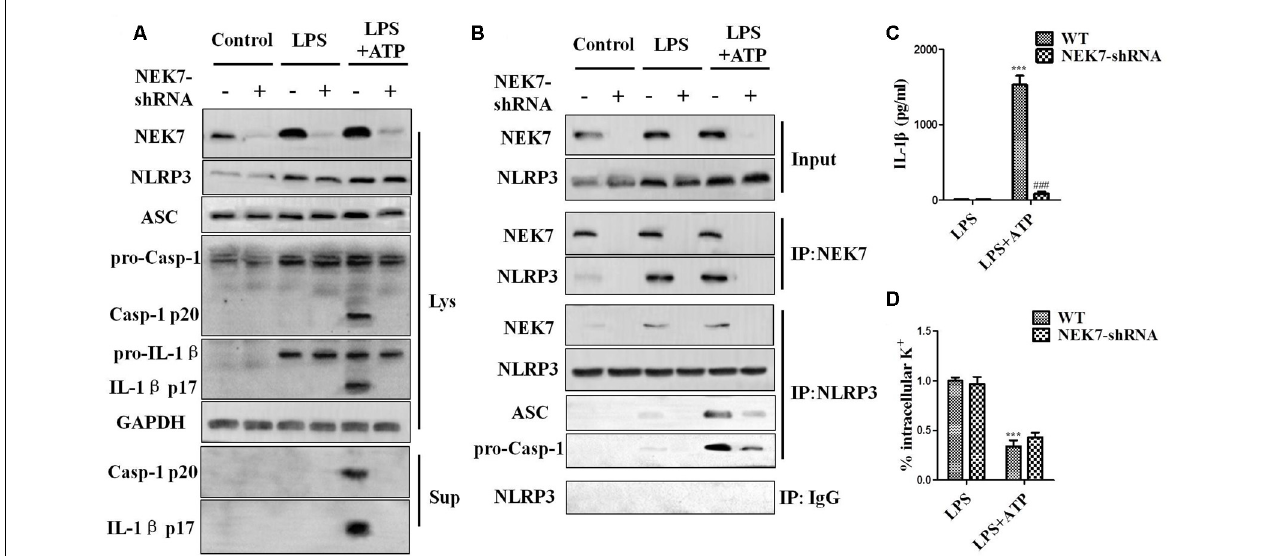
FIGURE 5 | NEK7 knock-down attenuates NLRP3 inflammasome activation. Primary cortical neurons were transduced with NC-shRNA or NEK7-shRNA, and untreated or stimulated with lipopolysaccharide (LPS) or LPS + ATP. (A) Caspase-1 and IL-1 β in the supernatant (Sup). and cell lysate (Lys). were analyzed in stimulated NC-shRNA- or NEK7-shRNA primary cortical neurons. (B) Co-immunoprecipitation (CoIP) analysis of the interaction between NEK7 and NLRP3 and the assembly of NLRP3 inflammasome. (C) IL-1 β release was measured. (D) Analysis of intracellular potassium (K + ) in each condition. Data are represented as the means ± SEM, n = 4. ∗∗∗ p < 0.001, vs. LPS. ### p < 0.001, vs. WT.